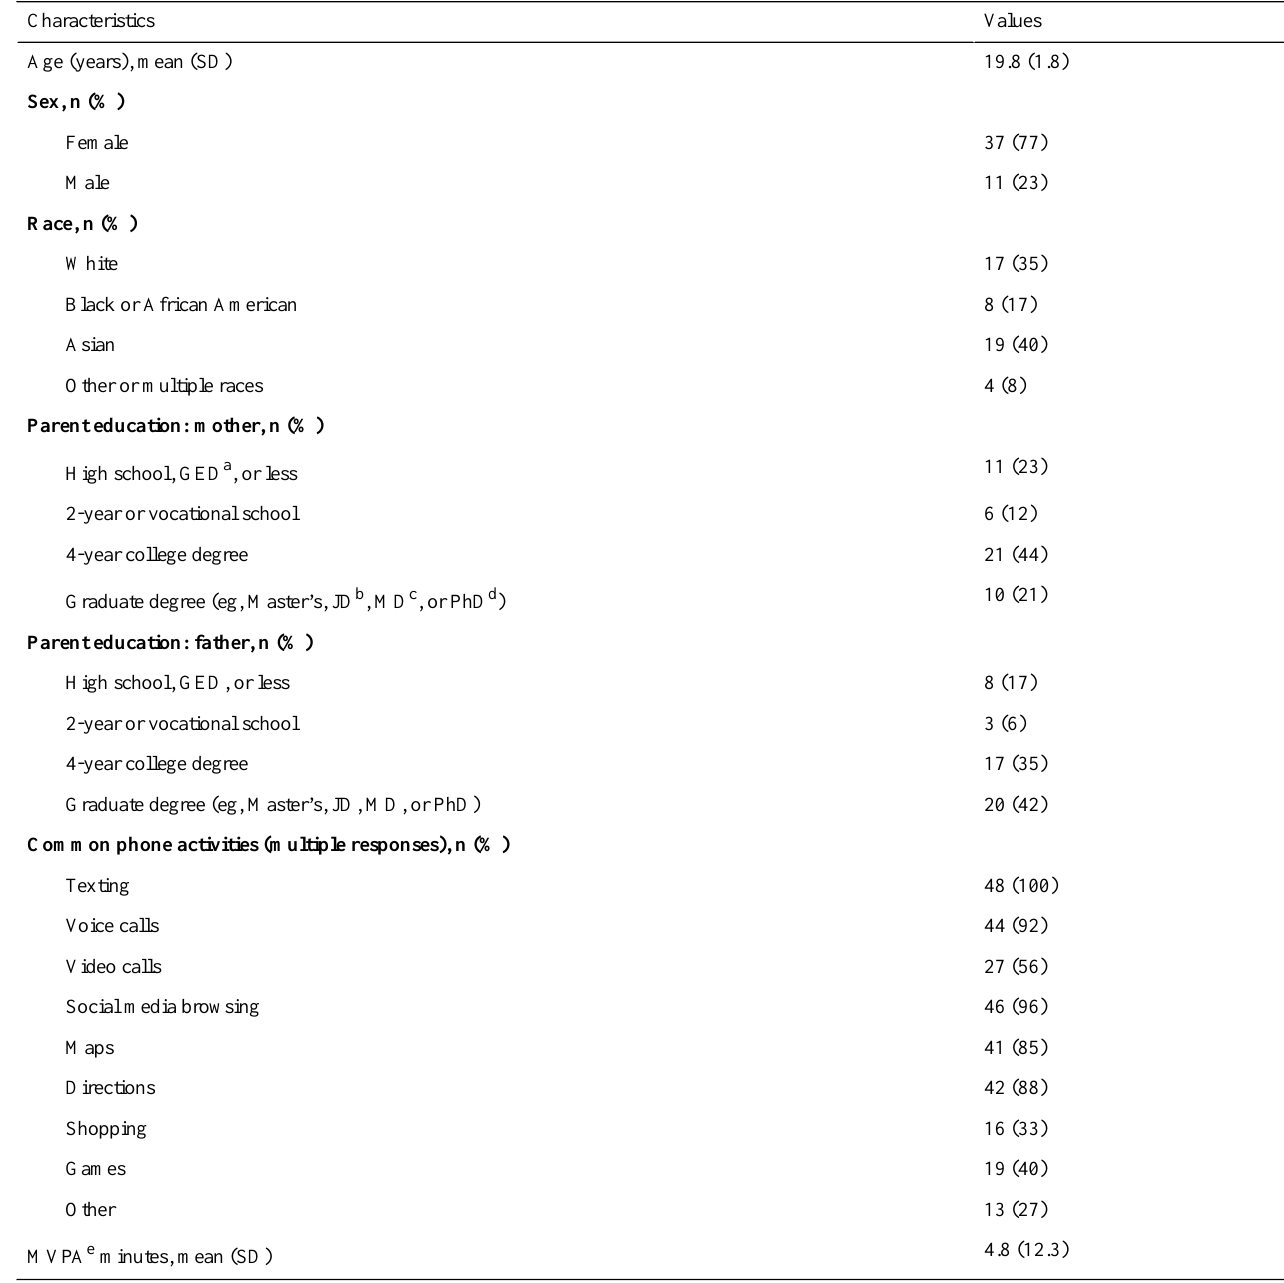
Table 1. Demographic characteristics of the study participants (N=48).